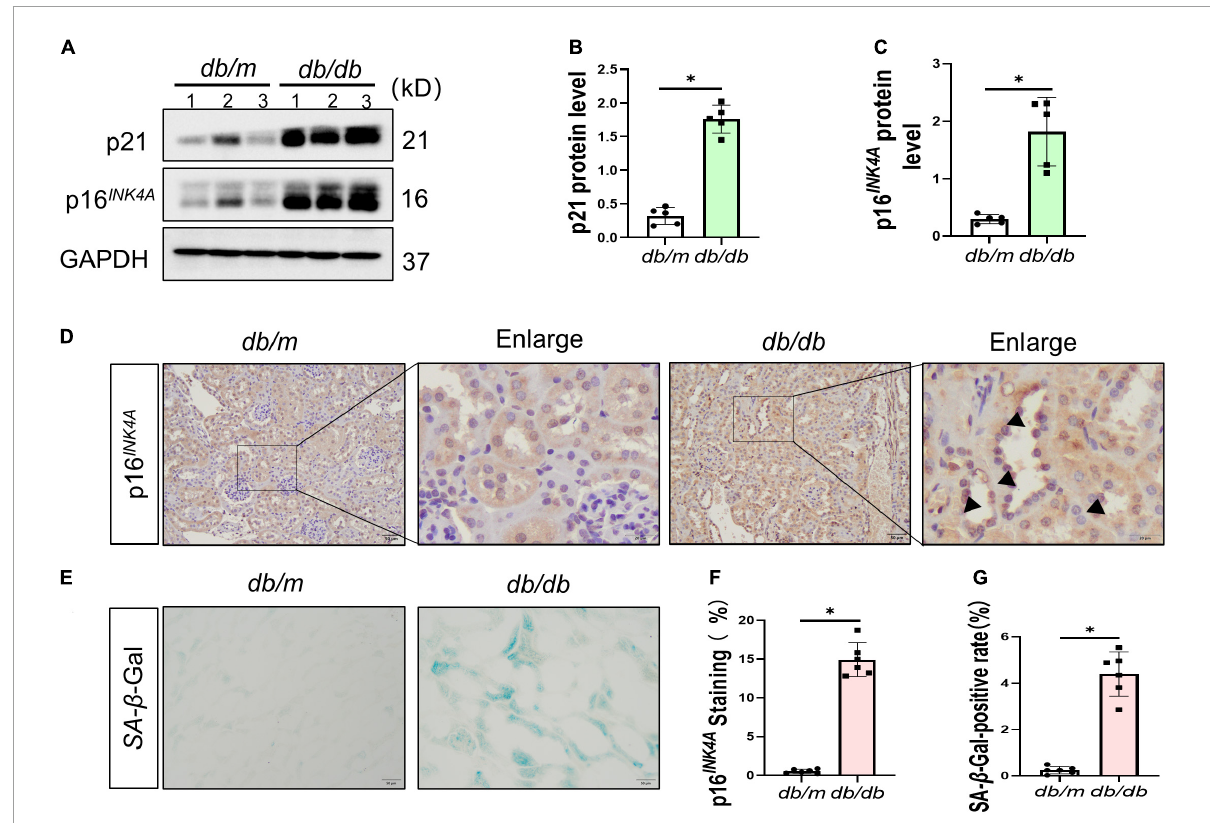
FIGURE2 Senescence in the process of diabetic kidney disease (DKD). Western blot analyses showed kidney p21 and p16 INK 4 A protein in renal tissues. Representative Western blot (A) and quantitative data (B,C) are presented. (D,F) Immunohistochemical staining showed p16 INK 4 A expression in db/db mice and db/m mice diseased kidneys. Black arrows indicate positive staining in tubules. Boxed areas are enlarged. Bar = 20 µ m. (E,G) Detection of SA- β -galactosidase (SA- β -Gal) activity in renal tissue. (E) Representative images of renal tissues are shown. Scale bar = 50 µ m. The ratio of SA- β -Gal-positive cells is presented in the panel (G) . All data are presented as mean ± standard deviation (SD) from three independent experiments. n = 5; ∗ P < 0.05 vs. db/m